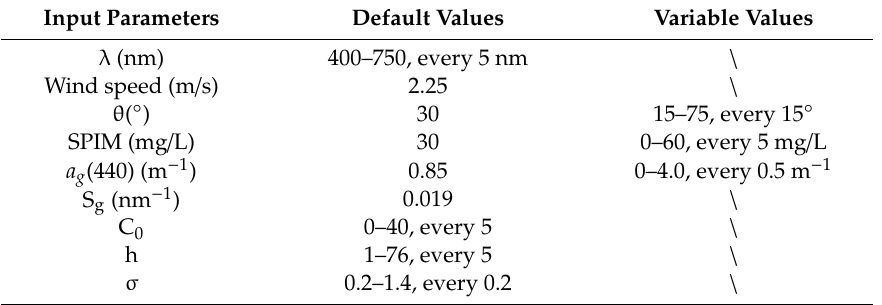
Table 2. Input parameters of Ecolight simulation: Solar zenith angle ( θ ), suspended particulate inorganic matter (SPIM), absorption coe ffi cient of colored dissolved organic matter (CDOM) at 440 nm ( a g (440)), and spectrum shape of CDOM absorption coe ffi cient (S g ). C 0 , h, and σ are structure parameters of Chl a (z)